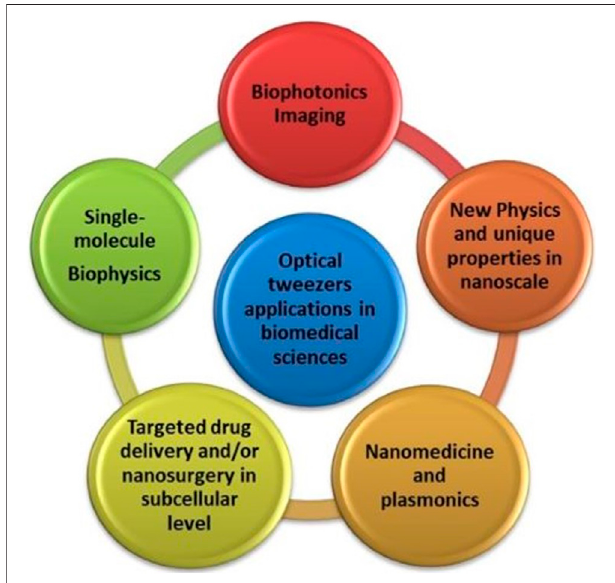
FIGURE 5 | Schematic illustration of some interconnected components of advanced Biophotonics techniques for cellular and molecular manipulation through optical